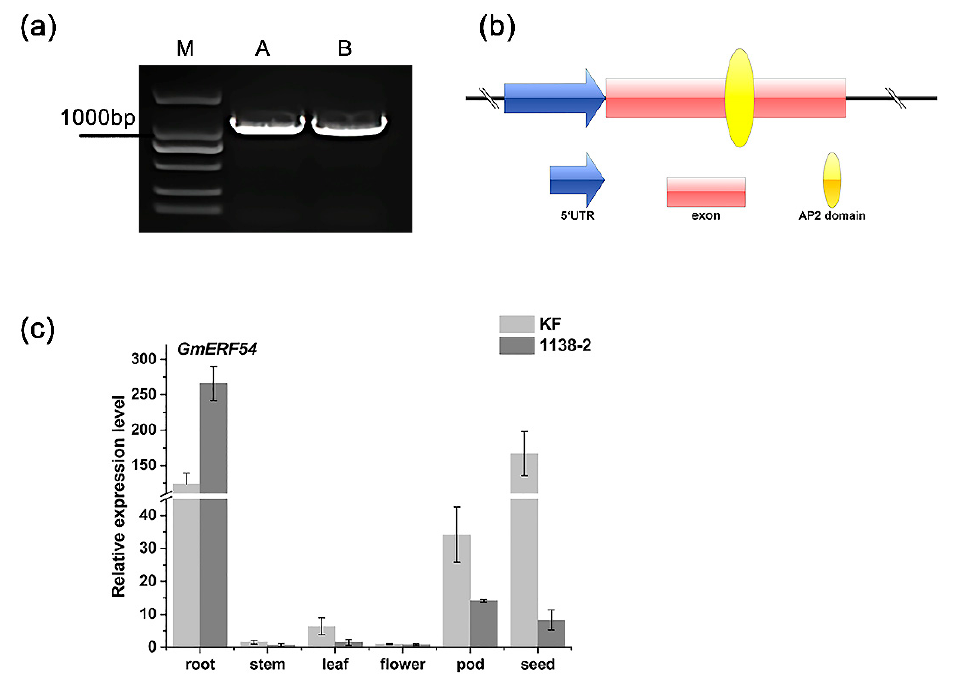
Figure 2. Sequence and expression analysis of GmERF54 . ( a ) Agarose electrophoresis of GmERF54 PCR products. M: DNA molecular marker (2000 bp); A: GmERF54 product amplified in cDNA; B: GmERF54 product amplified in DNA. ( b ) Schematic diagram of the GmERF54 gene structure. UTR, untranslated region. ( c ) Expression analysis of GmERF54 in different soybean tissues of KF and 1138–2 ( n = 3). Roots, stems and leaves of plants at the V4 stage, flowers of plants at the R2 stage, and pod skins and seeds of plants at 15 days after flowering were used for tissue expression analysis. According to the 2 − ∆∆ C T method [58], the relative expression levels were normalized to the housekeeping gene Gmtubulin in the same tissue at the same time, and were relative to the expression in flowers of KF (expression value in KF flowers = 1). Error bars denote ± SD.